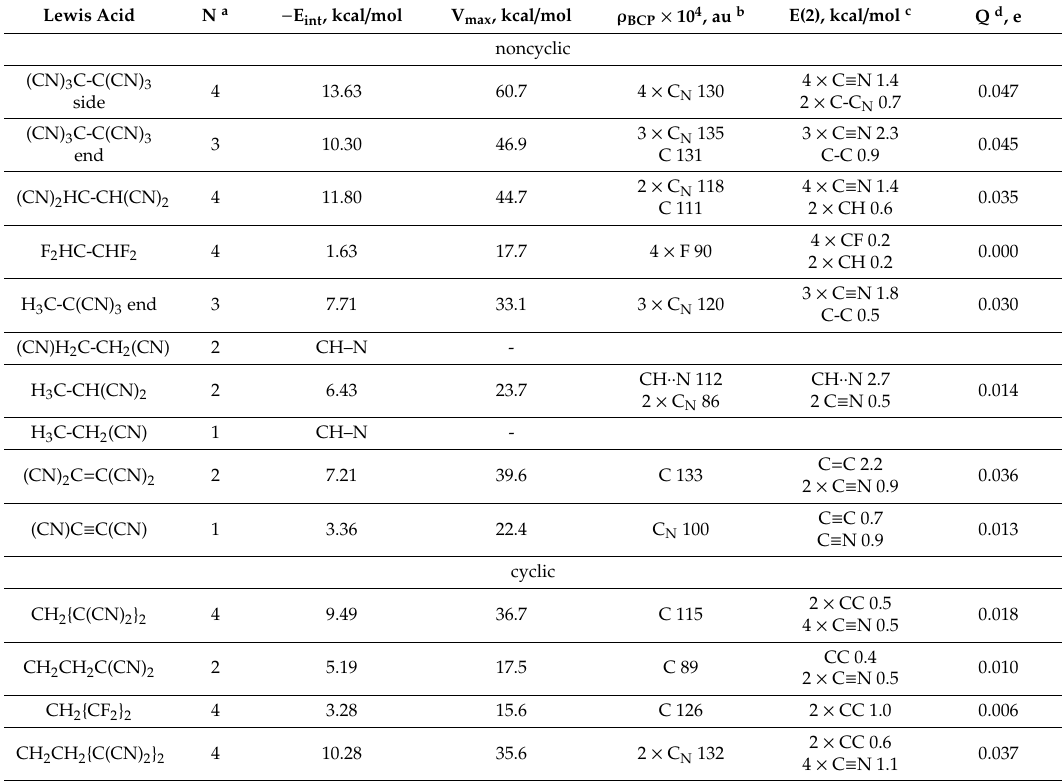
Table 1. Interaction energy, maximum of monomer molecular electrostatic potential (MEP), bond critical point density, natural bond orbital (NBO) charge transfer energy, and total charge transferred in complexes with NH 3